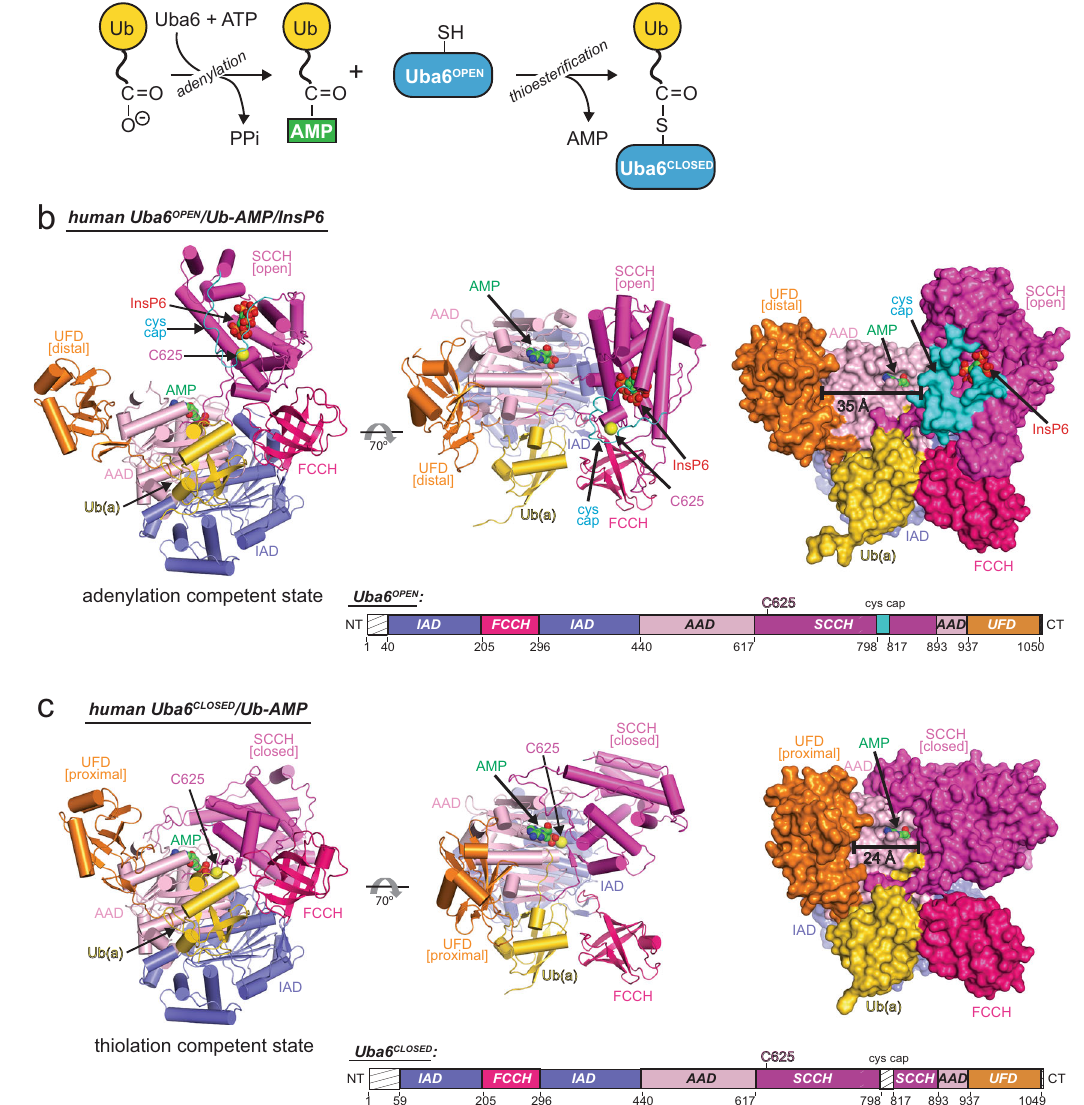
Fig. 1 | Overall architecture of Uba6/Ub-AMP complexes in open and closed states. a Schematic representation of Uba6~Ub thioester formation reaction. b CartoonrepresentationofcrystalstructureofUba6/Ub-AMP/InsP6intheopenE1 conformation.IADdomainisinslate;AADisinpink;FCCHisinhotpink;SCCHisin magenta; UFD is in orange; cys cap is in cyan; and Ub(a) is in gold. The catalytic